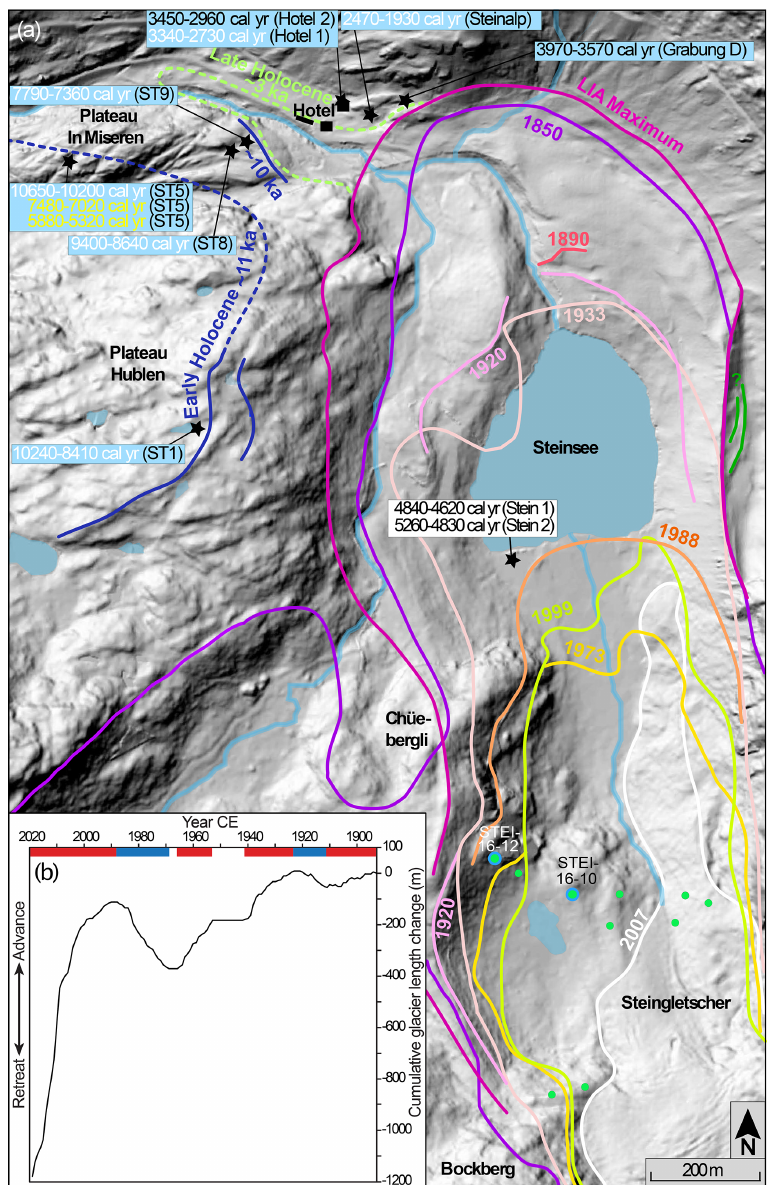
Figure 3. Map of Holocene extents of Steingletscher based on 10 Be moraine dating (see Fig. 1c) for the period between ∼ 11ka and LIA, and on historical topographic maps and data from the Swiss Glacier Inventory (CH-INVGLAZ), adapted from Wirz (2007) and King (1974), for the period between 1850 and 1999CE (a) , on shaded relief ALTI3D model by ©swisstopo. Black stars represent locations of radiocarbon- dated organic material and corresponding calibrated ages from King (1974) (in blue boxes; black numbers are maximum ages and white numbers are minimum ages for moraine deposits or glacier retreats/advances; yellow ages correspond to certain pollen assemblages) and from Hormes et al. (2006) (in white box). Bedrock sample locations on Chüebergli and Bockberg riegels are shown as green dots, and samples STEI-16-10 and -12 are highlighted with blue rims. (b) Length measurements of Steingletscher since 1893 (from GLAMOS, 2020). Red and blue bars correspond to trends of glacier retreat and advance, respectively; intervals of glacier stagnation are in white.